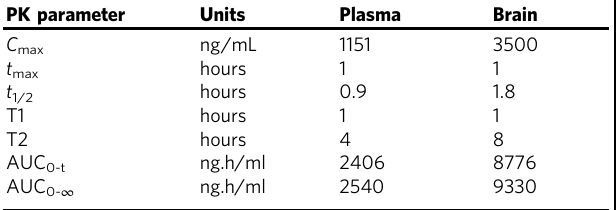
Table 3 Felodipine plasma and brain concentration in mice after single i.p. injection